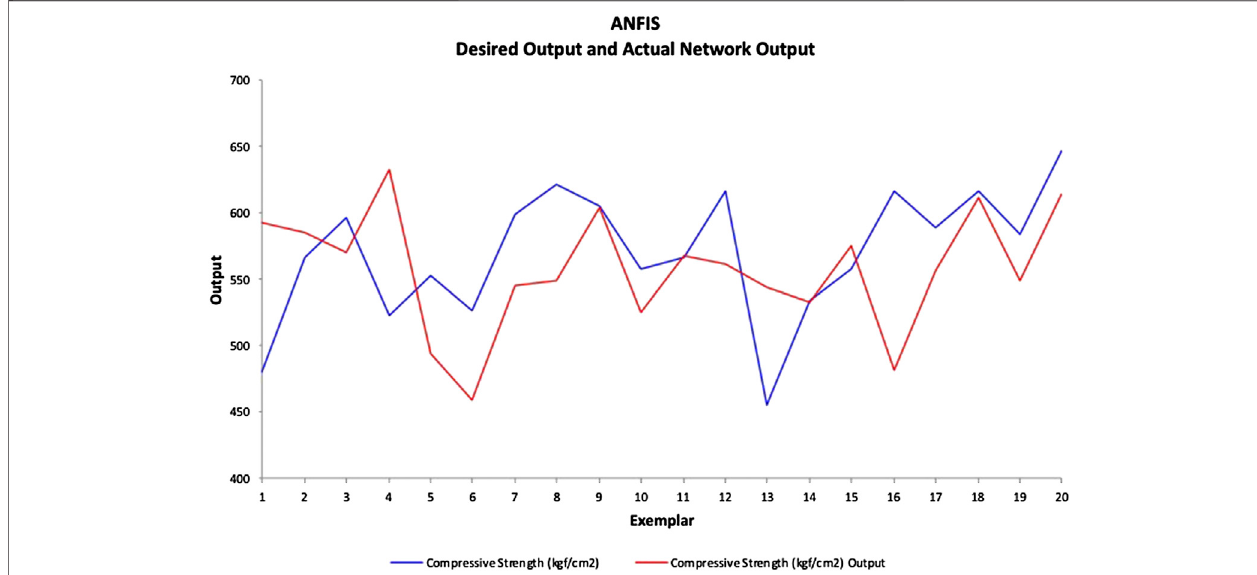
FIGURE 18 | ANFIS model line